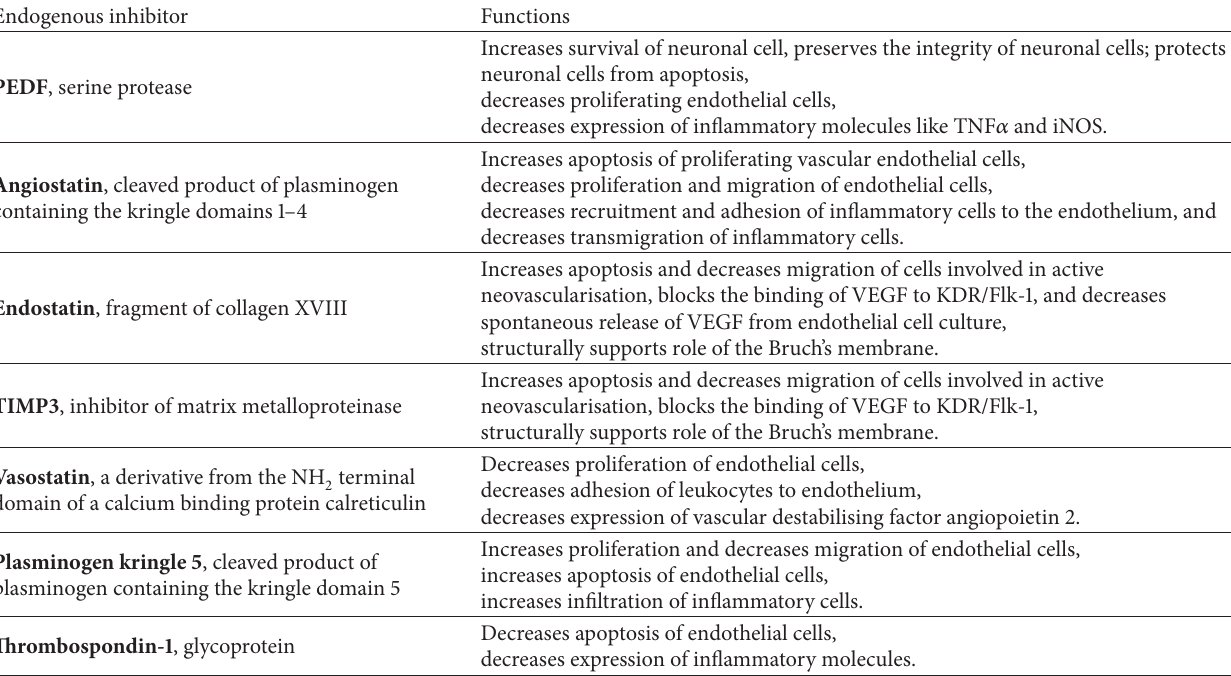
Table 1: Biological actions of endogenous inhibitors of